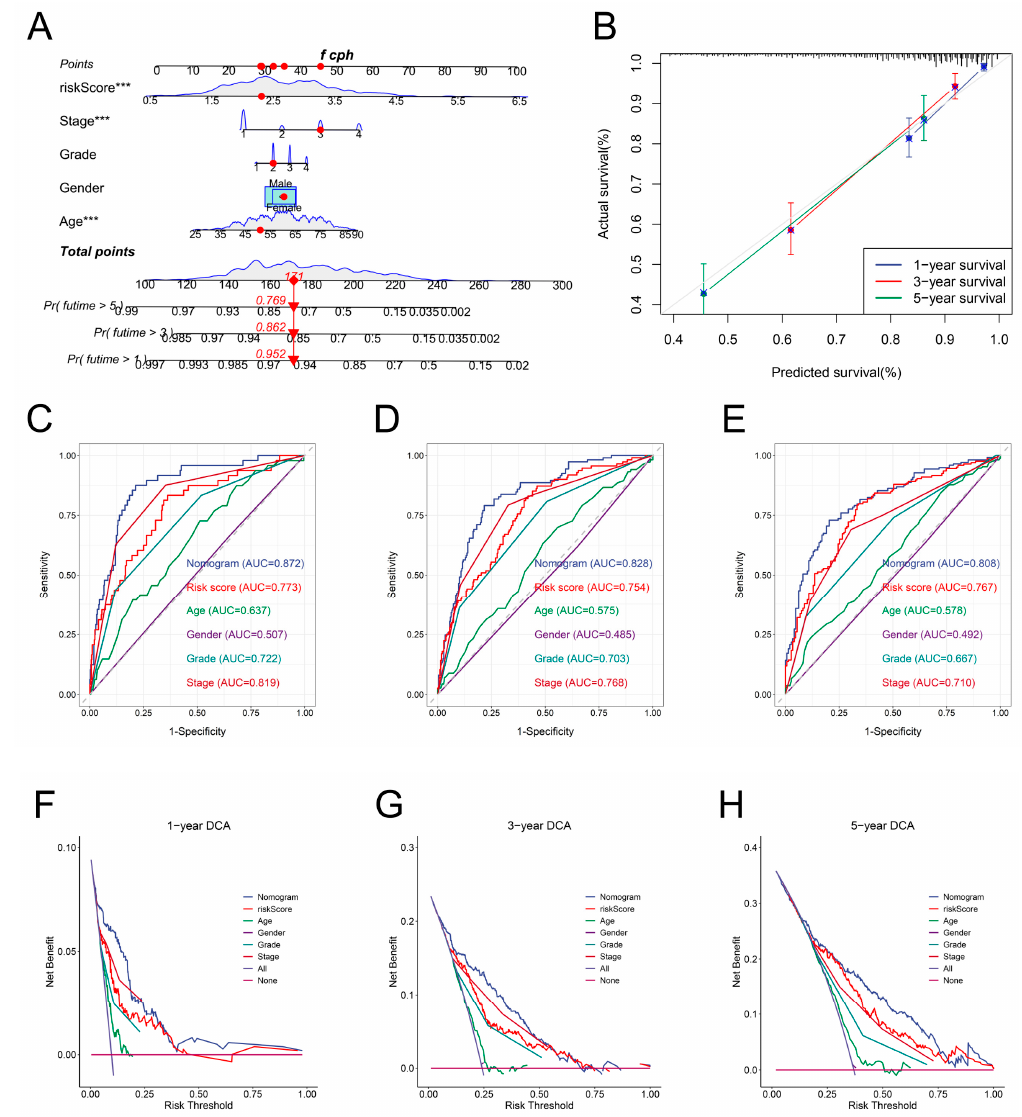
Figure 7. Development and internal validation of a nomogram. ( A ) Development of a nomogram based on the risk score, TNM stage, tumor grade, gender, and age. ( B ) Validation of the prediction effectiveness of the nomogram using calibration curves. ( C – E ) Comparing the ROC curves among the nomogram, risk score, age, gender, tumor grade, and TNM stage for 1-, 3-, and 5-year OS pre- diction. ( F – H ) Comparison of net benefits among the nomogram, risk score, age, gender, tumor grade, and TNM stage using DCA curves. *** p < 0.001.